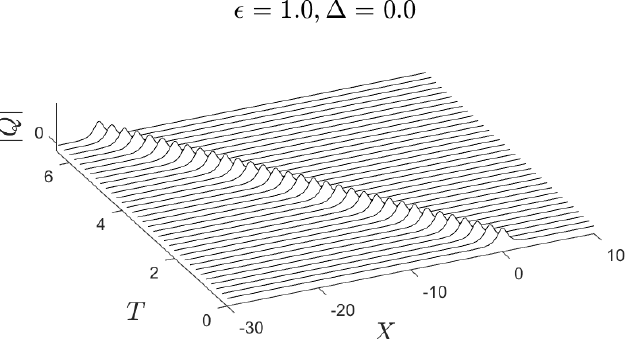
Figure 4. Case 2: Constant amplitude moving soliton from Equation (7) when (cid:101) = 1.0, M = 2, K = − 2, and ∆ =